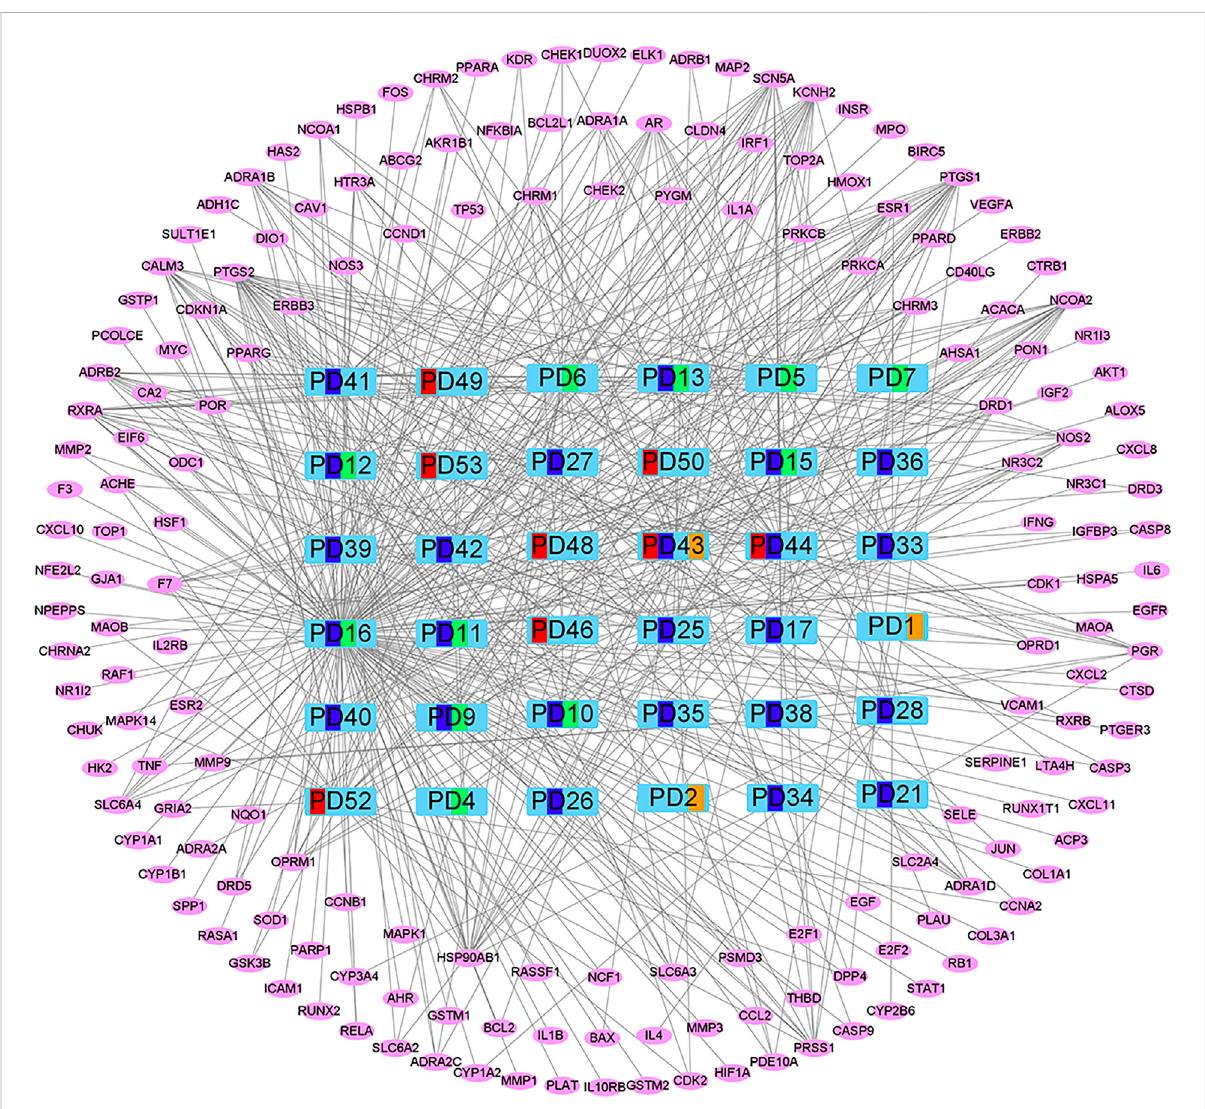
FIGURE 3 “ Components – Targets – Pathway ” network. Green represents Coptis Chinensis, dark blue represents Phellodendron, red represents Pulsatilla, orange represents Cortex Fraxini, and pink represents